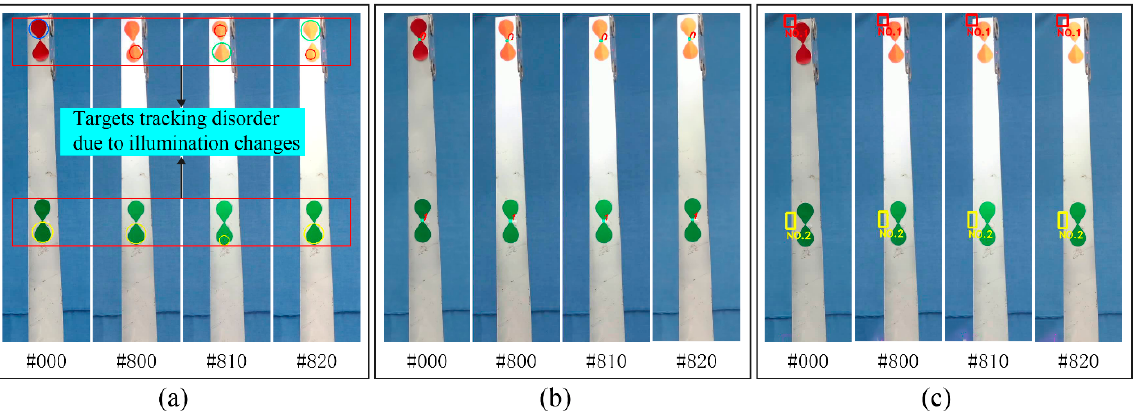
Figure 14. Different algorithms monitor the tracking situation of the algorithm under the condition of illumination change: ( a ) color matching algorithm; ( b ) optical flow method; ( c ) target-free DSST algorithm.